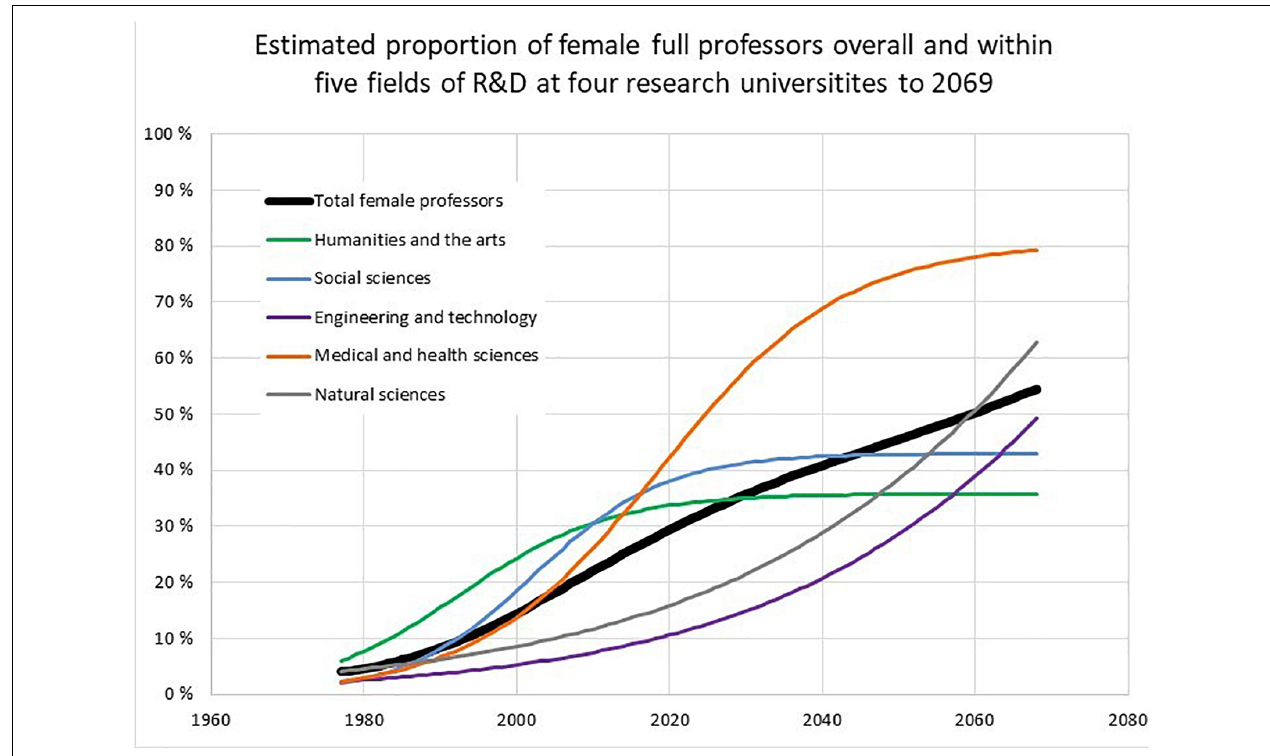
FIGURE 7 | Estimated proportion of female associate professors in four scientific fields at universities to